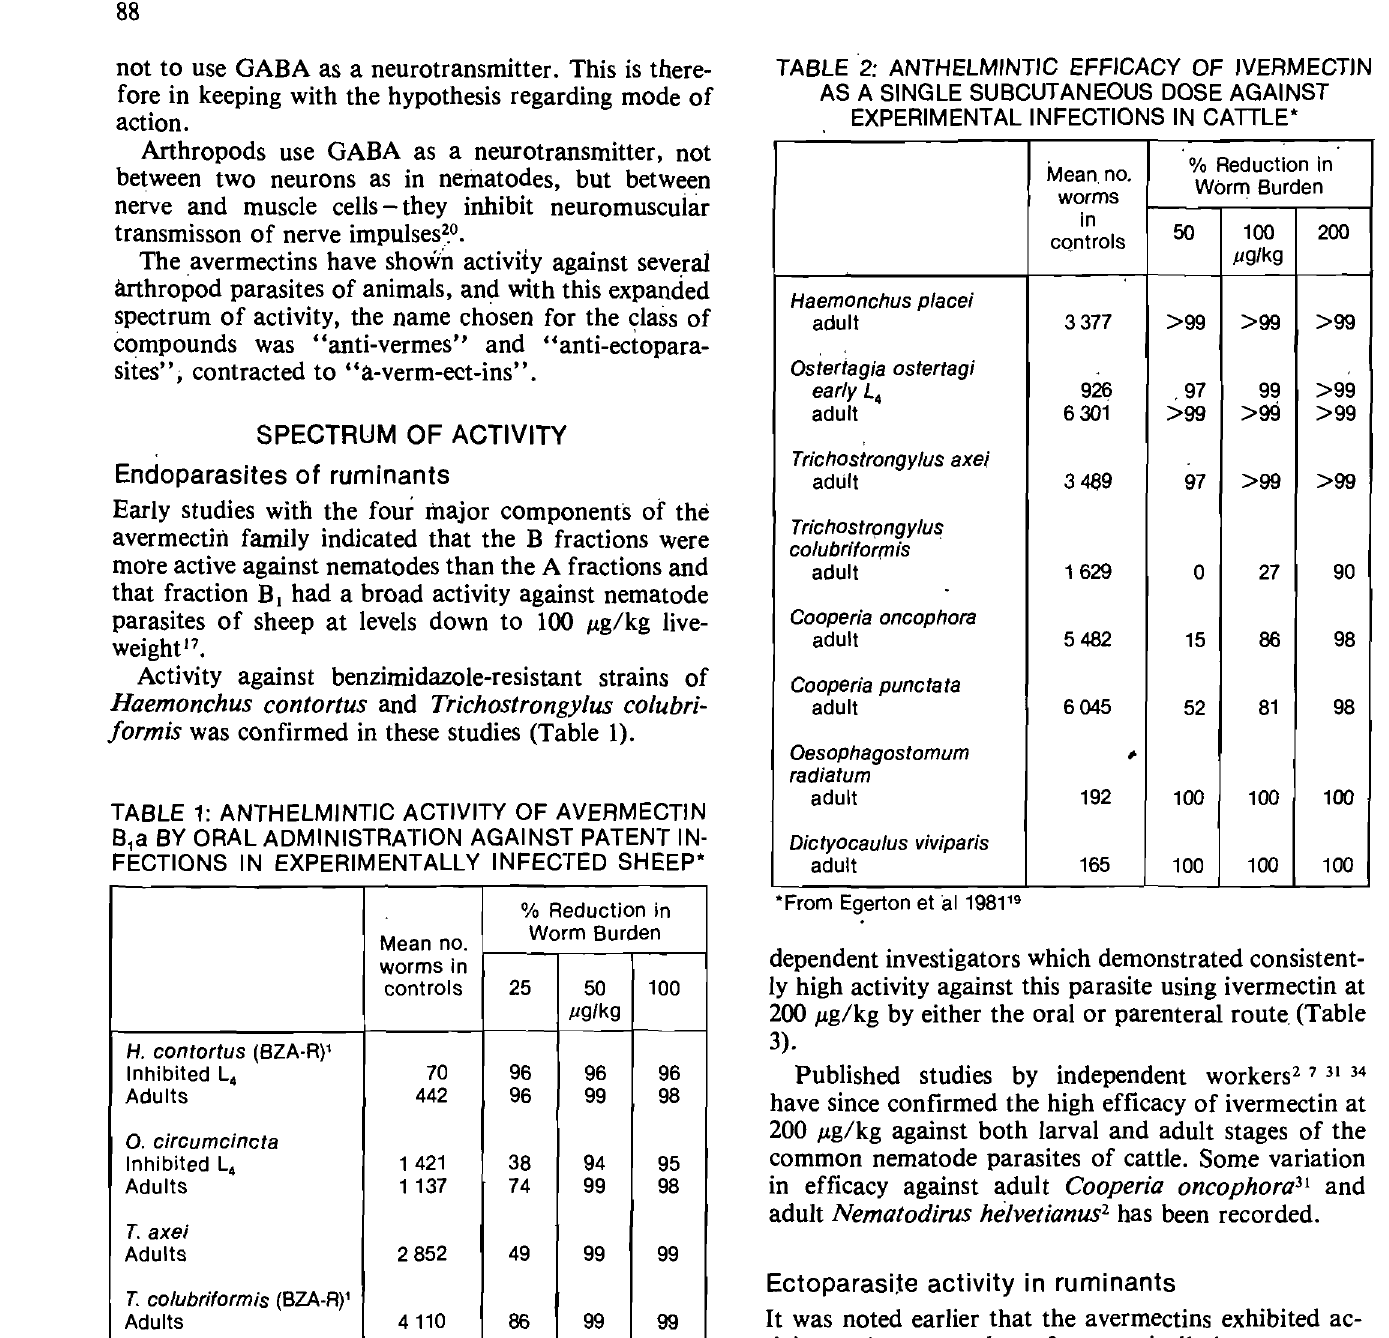
Mean no. worms in